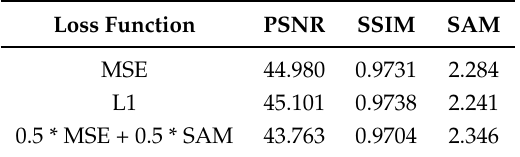
Table 6. Analysis of the influence for three loss